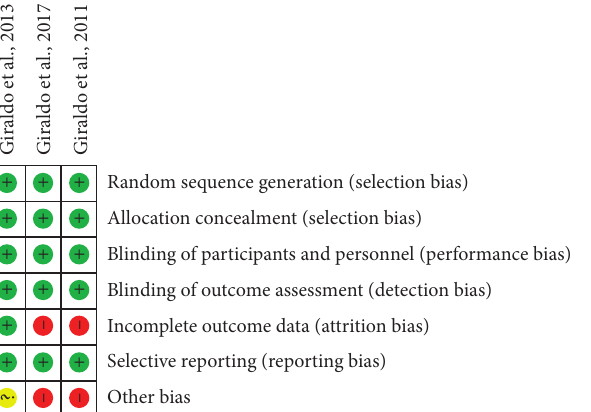
Figure 1: Traffic light of risk of bias. Each color represents the presence and absence of the bias presented in the last column.